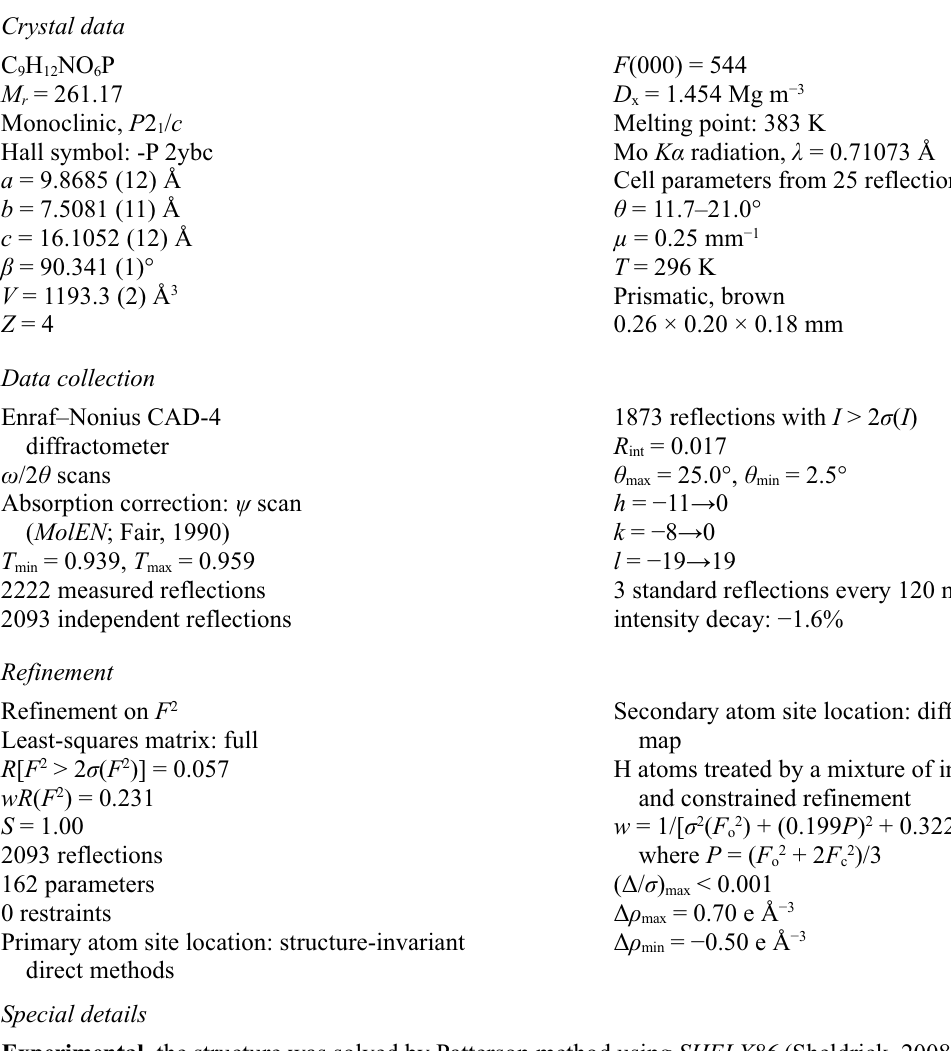
Figure 2 The partial packing figure ( PLATON : Spek, 2009) shows the formation of ring motifs through hydrogen bonding. Dimethyl [( S